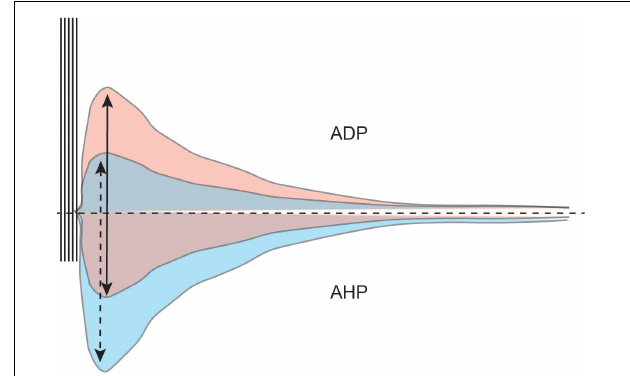
FIGURE 7 | The AHP modulates the size and duration of the ADP. A train of action potentials is typically followed by a hyperpolarization of the membrane potential (AHP, bottom half). The AHP modulates intrinsic excitability and the afterdepolarization (ADP, top half). However, cholinergic activation in the LEC diminishes the AHP and unmasks the ADP. A larger AHP limits the size of the ADP (blue) while a smaller AHP allows for a larger ADP to develop